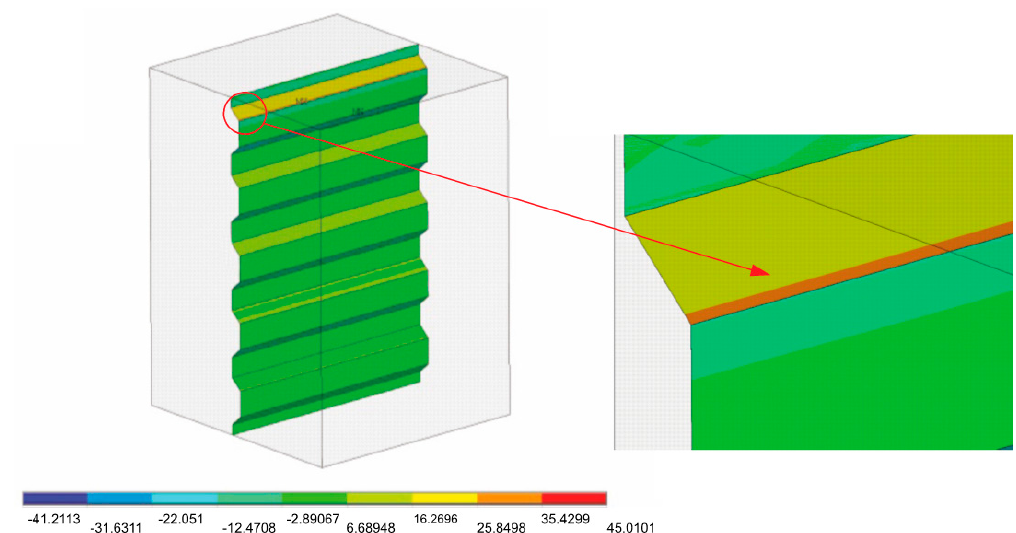
Figure 4. Pressure distribution on a coping surface and an enlarged image of the edge of the first groove. σ cont max = 45 MPa.